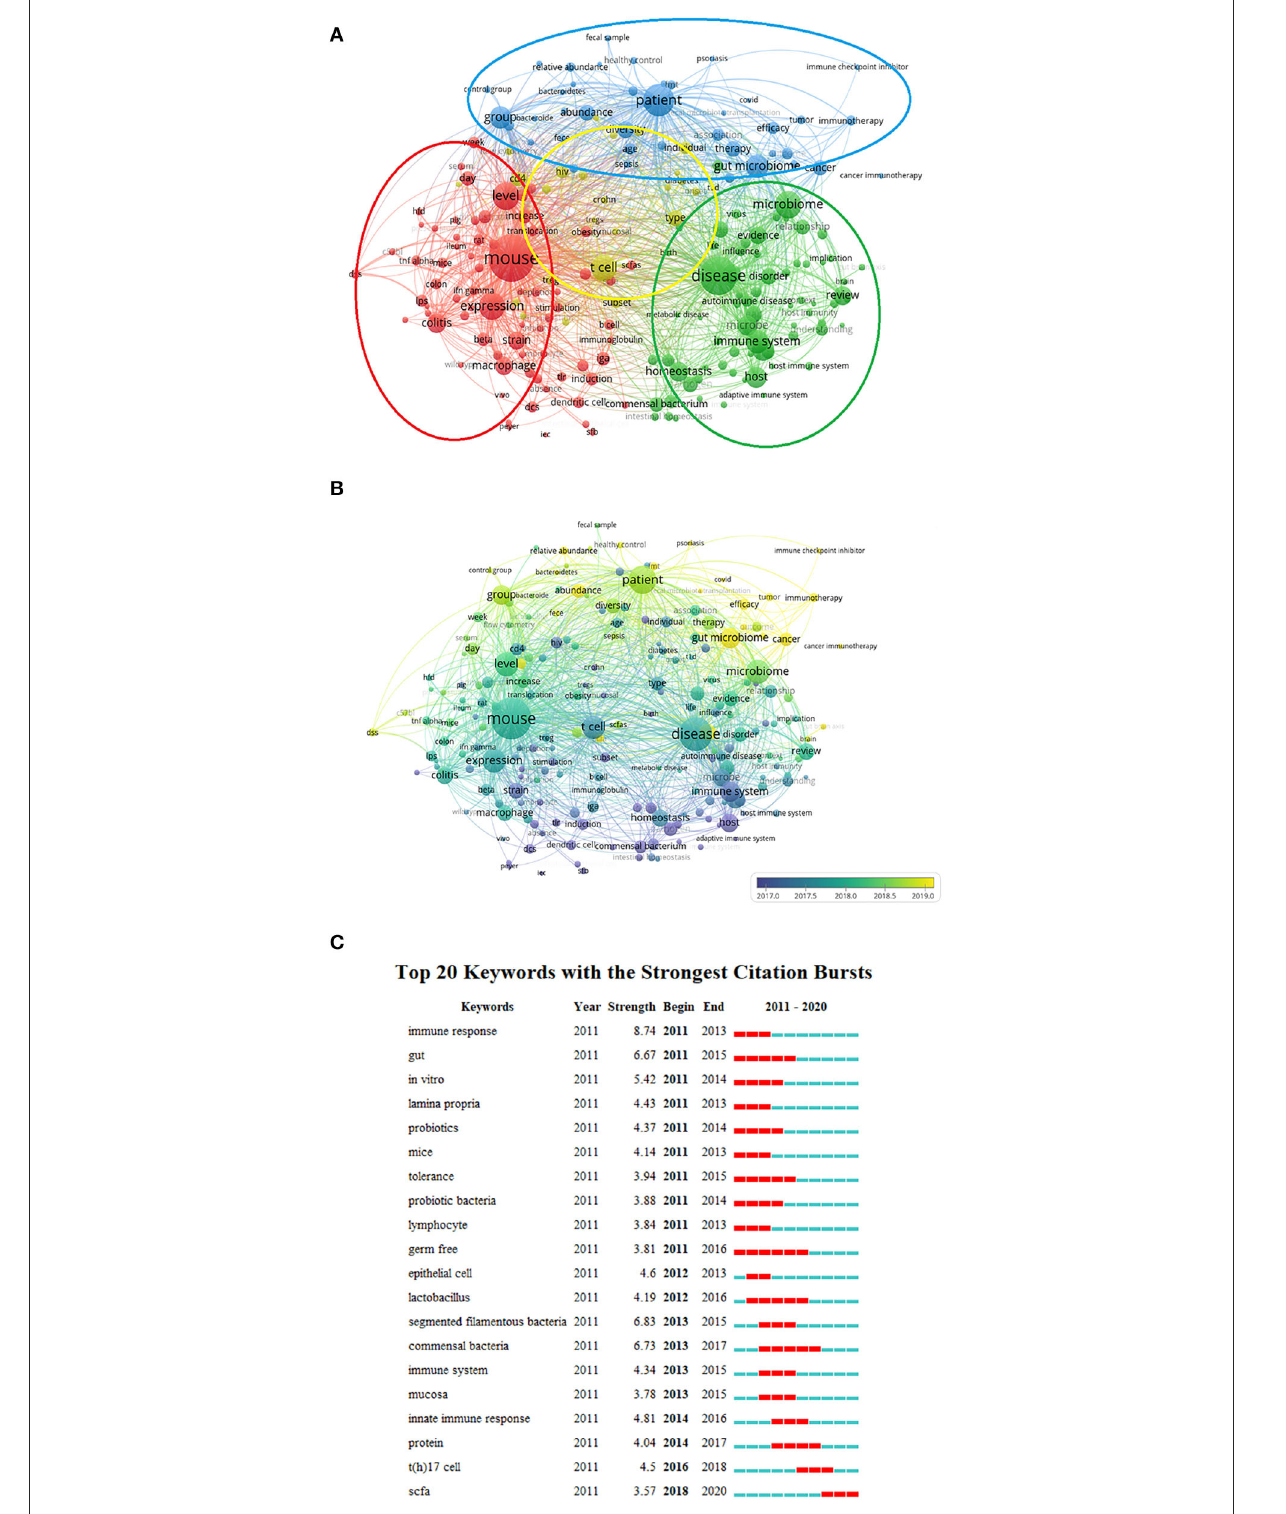
FIGURE7 Co-occurrence analysis of all keywords in the publications on gut microbiota and host immune response: (A) Mapping of the keywords in the field of gut microbiota and host immune response. The size of the circle represents the frequency of keywords, and different colors represent